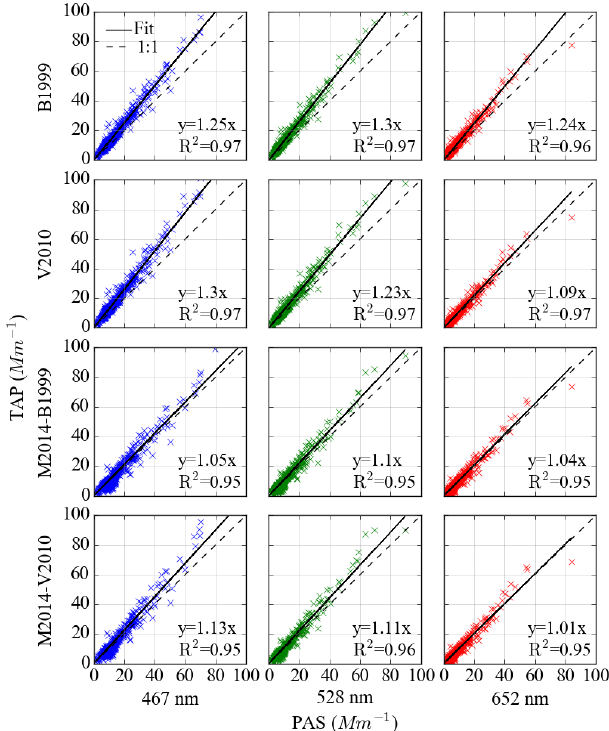
Figure 5. As Fig. 3 but for aged biomass burning aerosol over the Southeast Atlantic Ocean in August and September